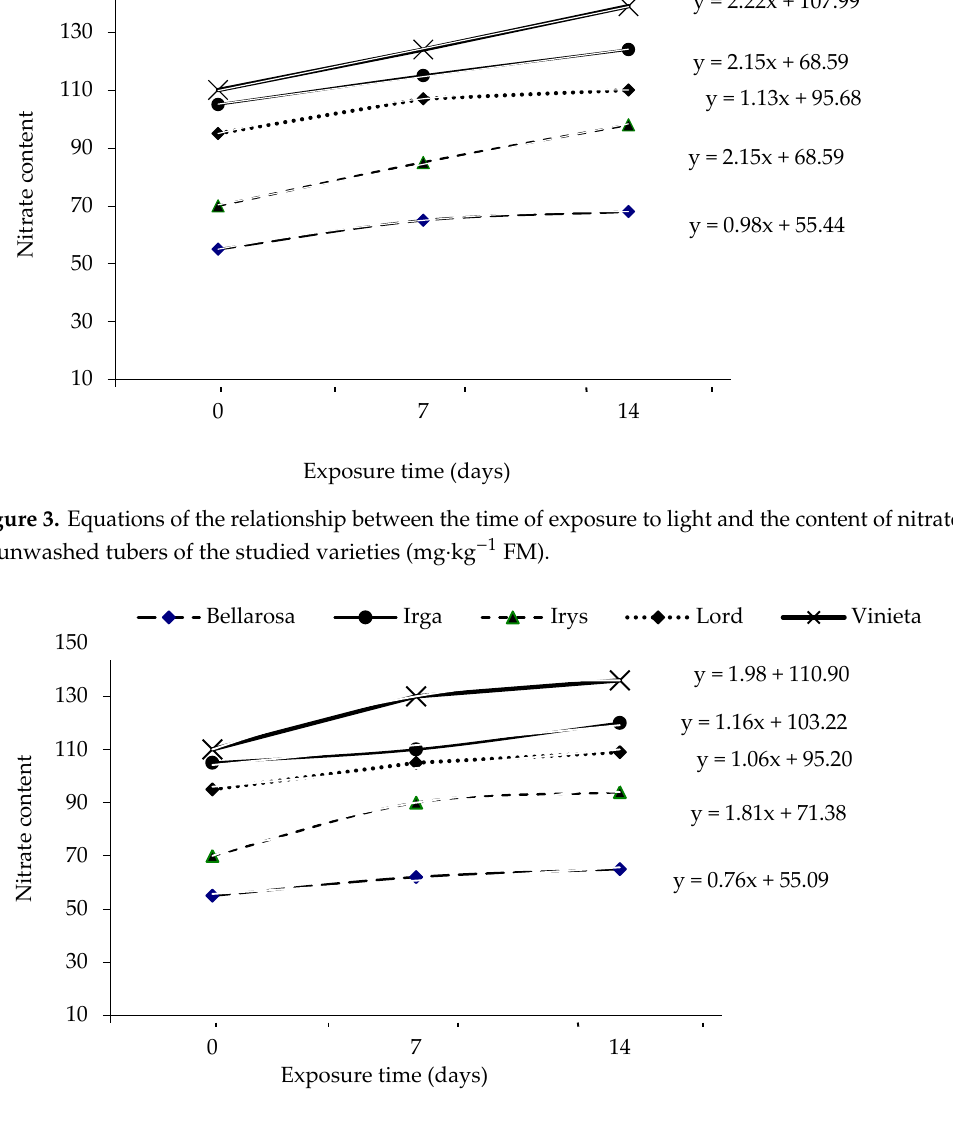
Figure 4. Equation of the relationship between the time of exposure to light and the content of nitrates in washed tubers of studied varieties (mg·kg − 1 FM).